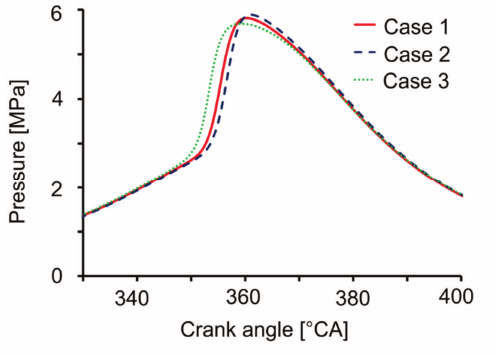
Fig. 3. Pressure in the cylinder for chosen cases (Table